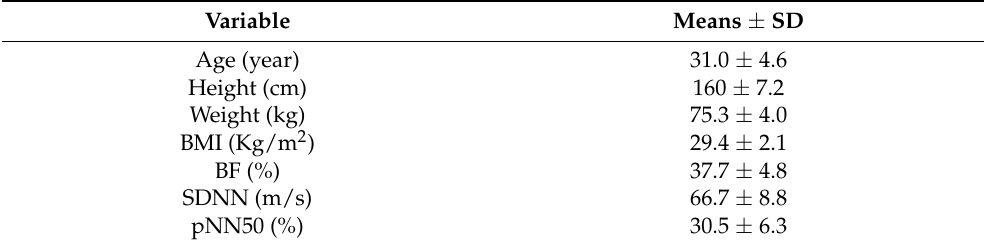
Table 1. Participant Baseline Characteristics ( n =